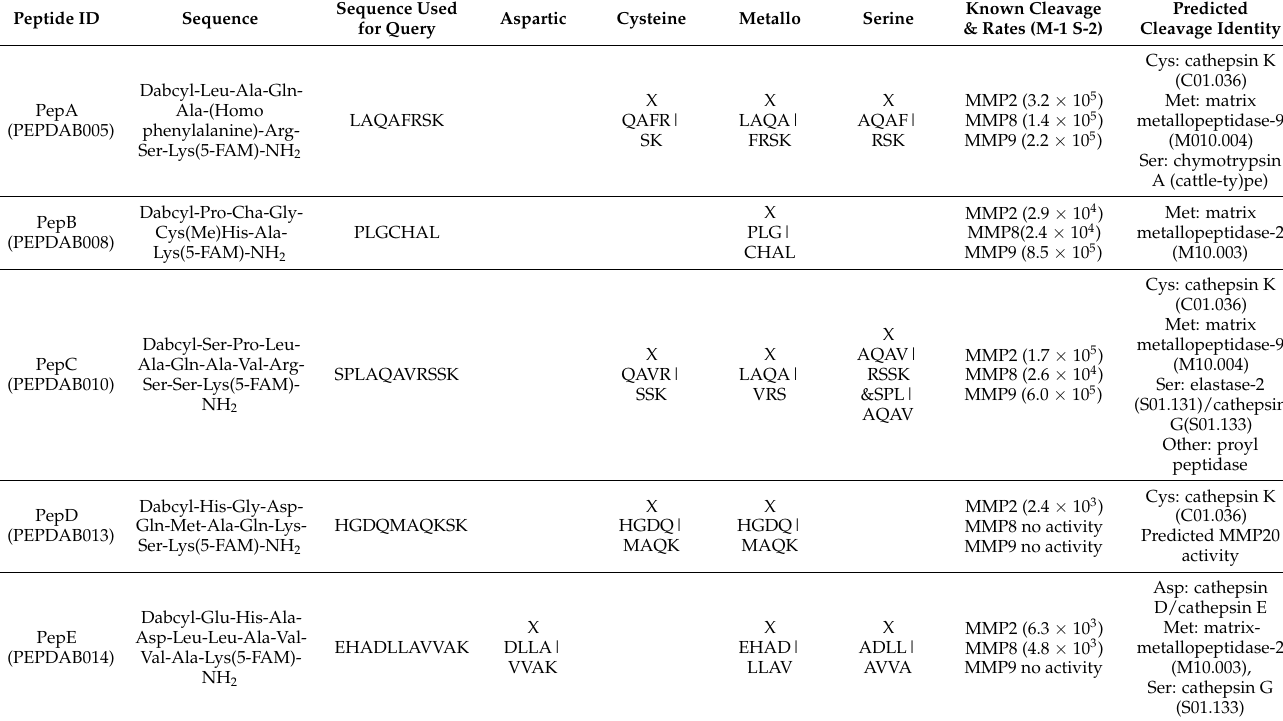
Table 2. Predicted and known cleavages rates, sites and effector protease identities for multiplexed peptides pepA–pepE used in this study. Predictions were derived from [21]. Cleavage rates adapted taken from [22,23]. Peptide